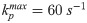
Filament distribution in the system with progressive gel front.The probability distribution of (a) detached and (b) attached filaments for the early state and (c, d) the late stage of membrane protrusion. The total number of filaments is constant and equal to 25 during the whole process. Here μ and σ are mean value and standard deviation of a normal distribution fitted to the data. Parameters are na = 0.1 nm−1, Fe = 12 pN, kpmax=60s-1 and vgmax=10nms-1.